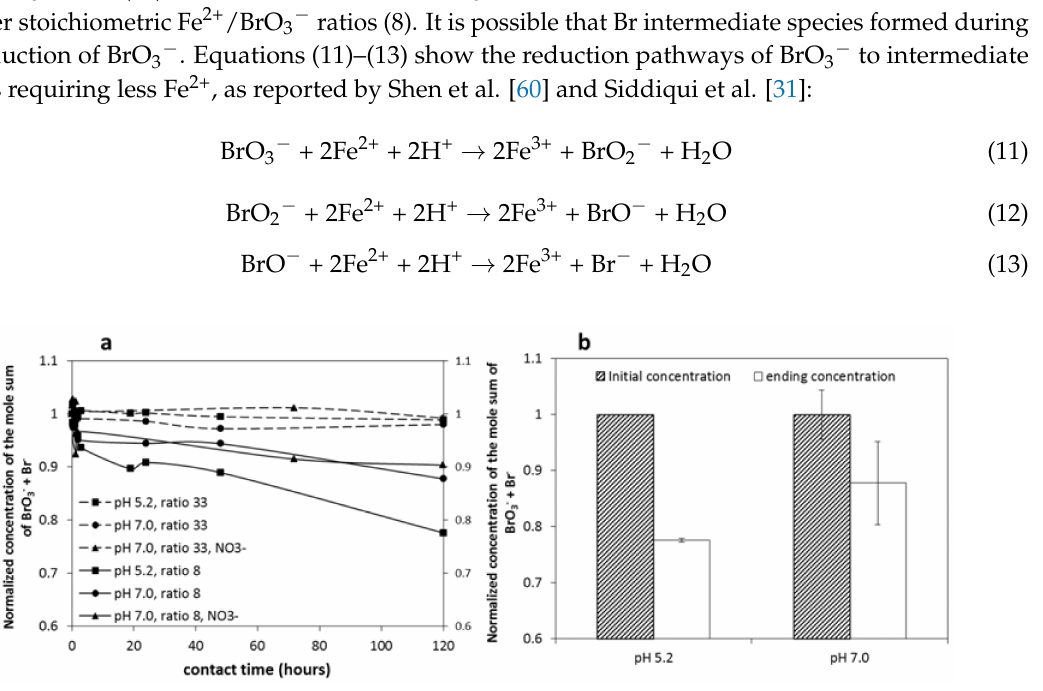
Figure 9. ( a ) Mole mass sum of BrO 3 − and Br − in all experiments with initial BrO 3 − concentration of 0.03 mM and ( b ) comparison of mole mass loss of BrO 3 − and Br − in 120 h between pH 5.2 and pH 7.0. Ratio means the initial ratio of Fe 2+ /BrO 3 − ( n =